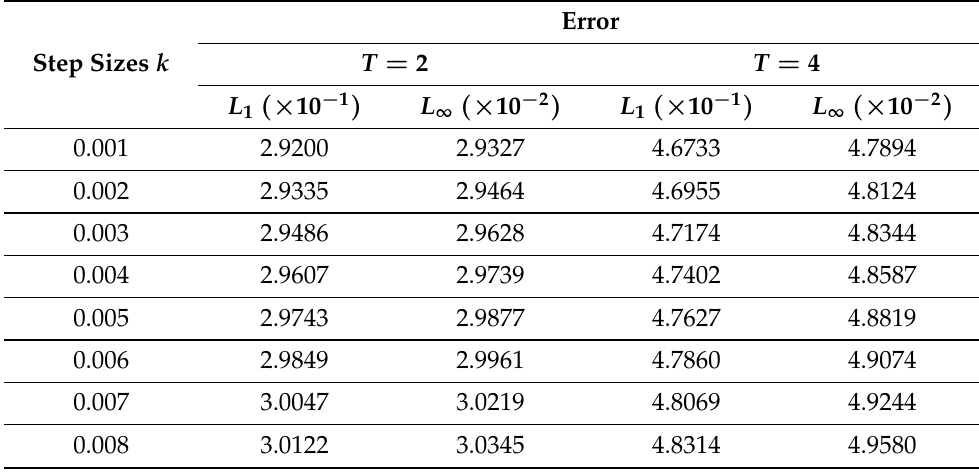
Table 2. L 1 and L ∞ errors for various k when h = π /10 when Scheme 2 is employed to approximate Numerical Experiment 1 at T = 2 and T = 4.